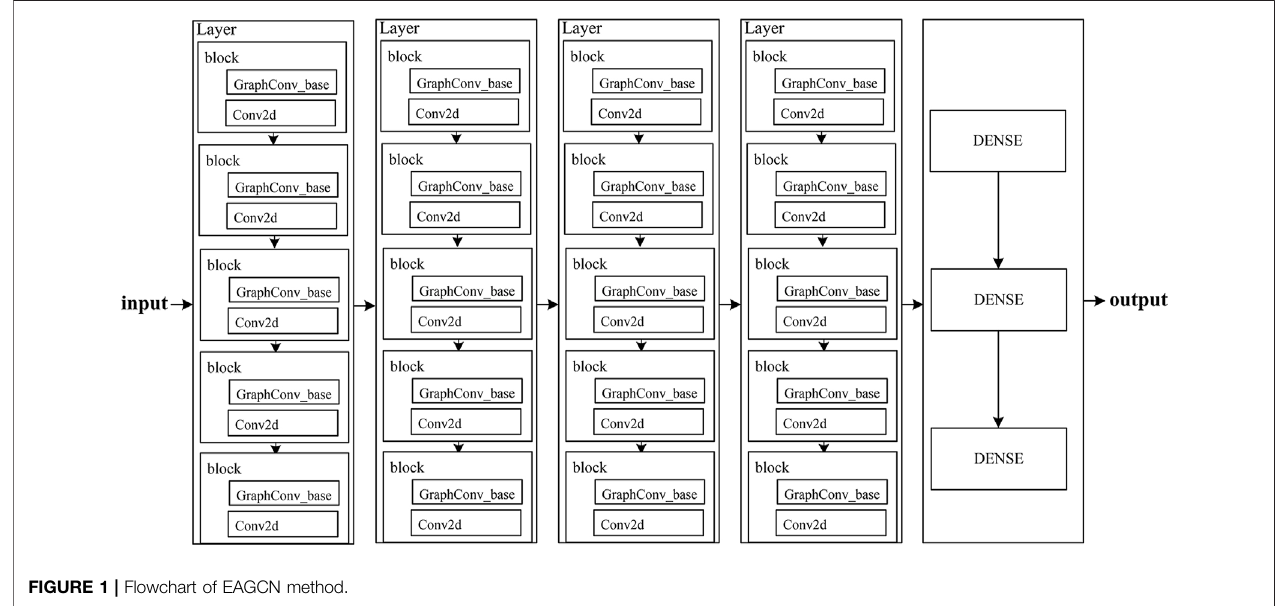
FIGURE 1 | Flowchart of EAGCN